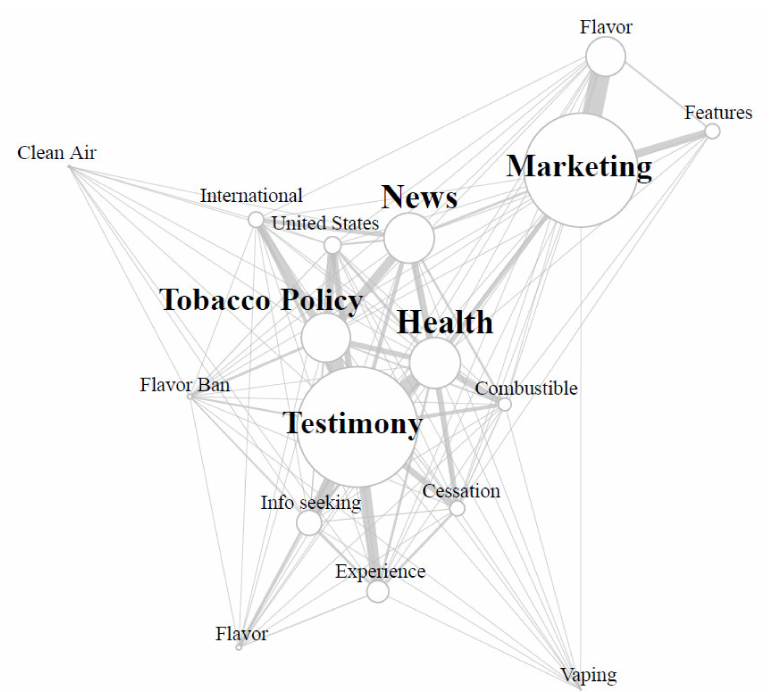
Figure 1. Co-occurrences of themes in corpus tweets. Note: Size of circles represents tweet theme frequencies. Line size and position of circles represent frequency of co-occurrences. Larger lines indicate greater co-occurrence, circles closer to one another were more likely to